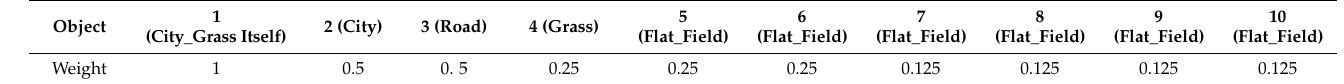
Table 4. Weights of all neighbor nodes.